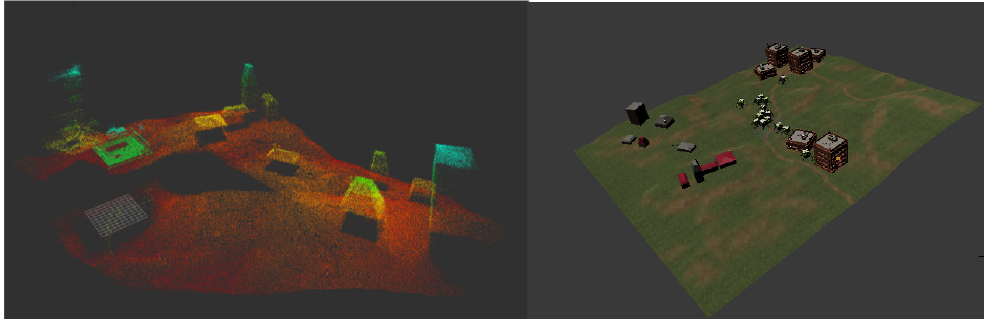
Figure 6. First scenario point cloud and Blender